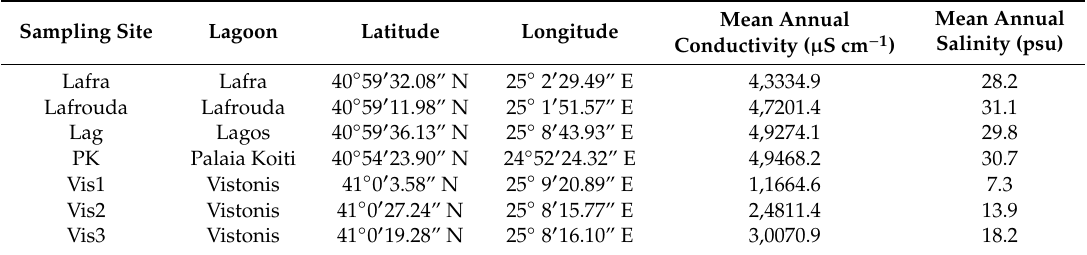
Table 1. Latitude, longitude, mean annual conductivity ( µ S cm − 1 ) and mean annual salinity (psu) per sampling